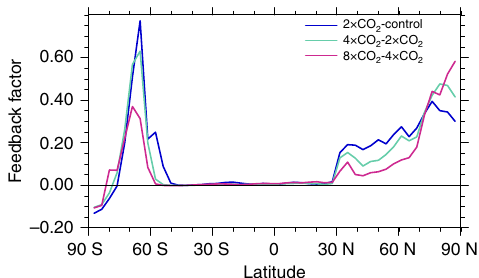
Fig. 2 Nonlinearity in the surface albedo feedback factor for three consecutive doublings of CO 2 . The feedback factor, de fi ned as the ratio of the magnitude of the albedo feedback on the Planck feedback, is calculated using the radiative kernel technique 85 and zonal averages are plotted for three consecutive doublings of CO 2 concentrations in CCSM3. The global average feedback factor decreases 87 from 0.097 for 2xCO 2 – CNTL to 0.053 for 8xCO 2 – 4xCO research, and it is not yet clear if the response of the system has a direct impact on the original perturbation itself such that a closed feedback loop can be identi fi ed.